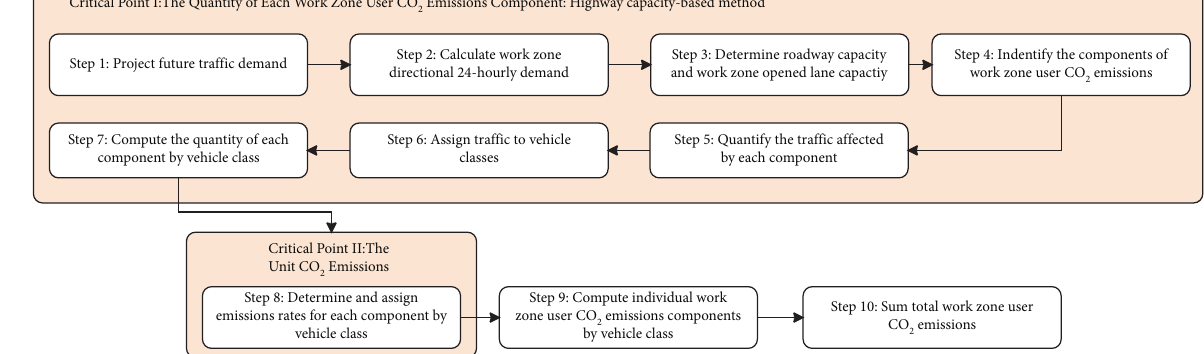
Figure 2: The framework of work zone user CO